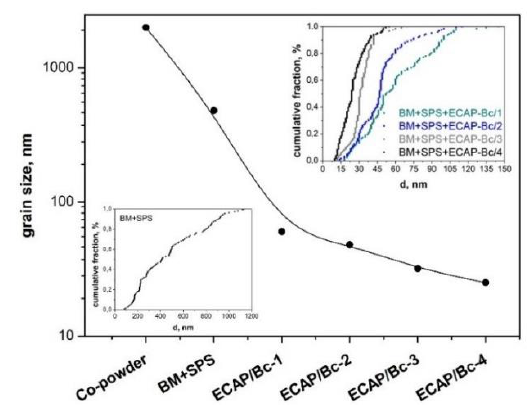
Figure 1. TEM (transmission electron microscope) extraction image showing the cobalt starting powder dimension; inset shows the powder size distribution obtained from 350 measurements performed on TEM.